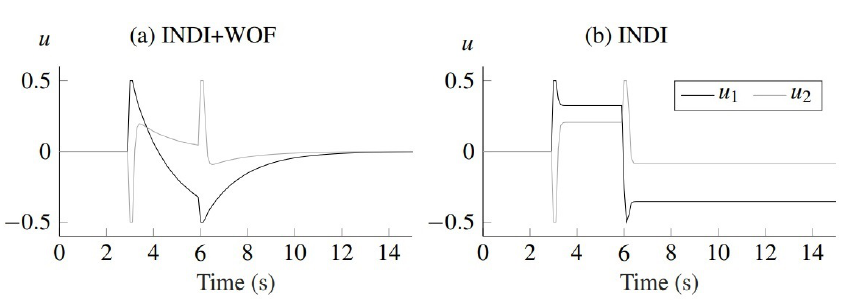
Figure 10. Numerical example: comparison of input signals between INDI+WOF and